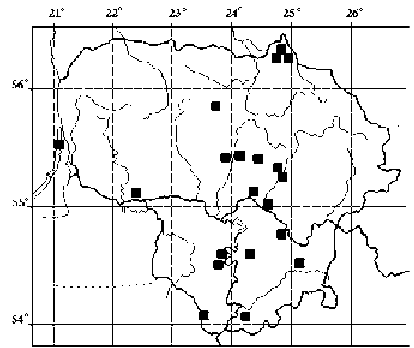
Fig. 15. Localities of Echinostelium minu tum (■) in